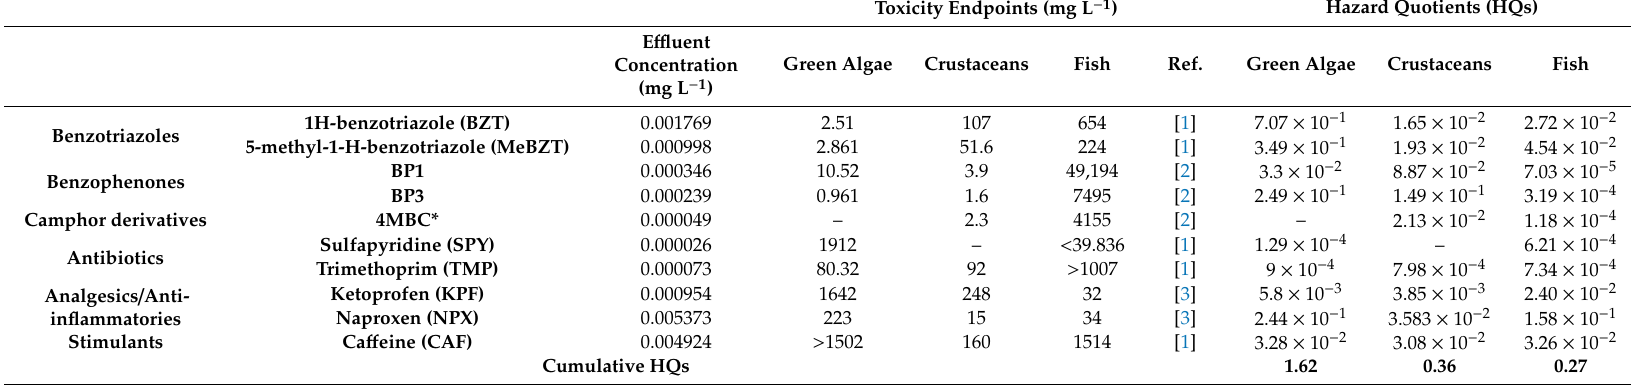
Table 2. Average HRAP e ffl uent concentrations (mg L − 1 ) (used as measured environmental concentrations, MEC), ecotoxicity endpoints used for the di ff erent trophic levels considered (mg L − 1 ) and hazard quotients (HQ) estimated. HQs have been estimated for those PPCP present in the e ffl uent with a frequency of detection ≥ 33.3% ( n ≥ 2 over